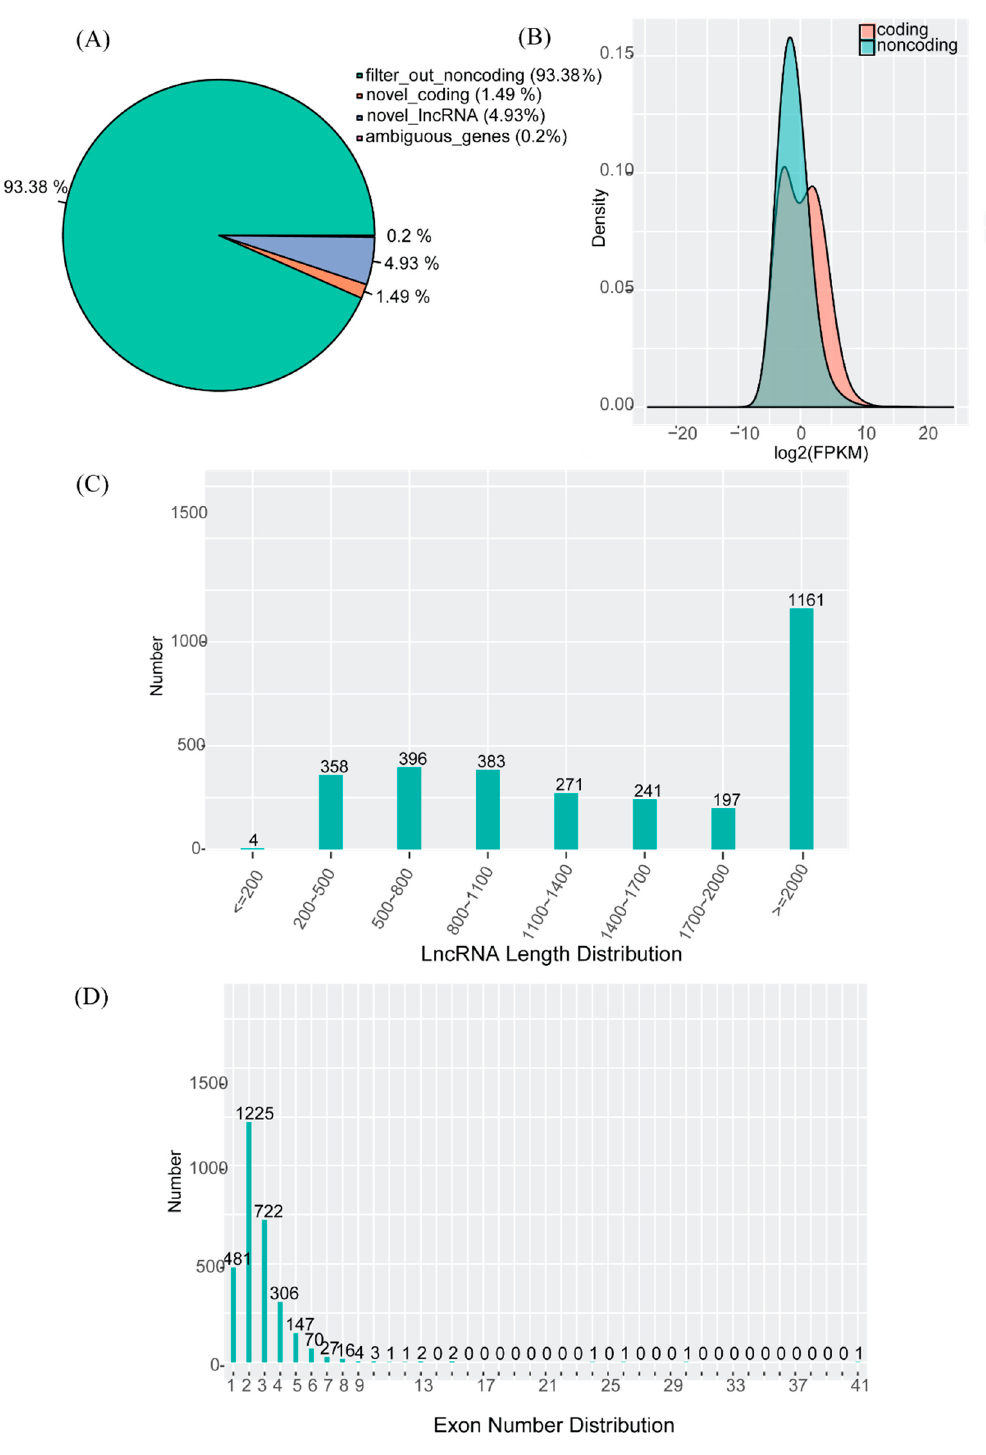
Figure 1. Statistics of horse placental lncRNAs identified in this study. ( A ) Percentage of potentially novel transcripts. ( B ) Expression levels of mRNAs and lncRNAs. ( C ) Length distribution of lncRNAs. ( D ) Exon number of lncRNAs.